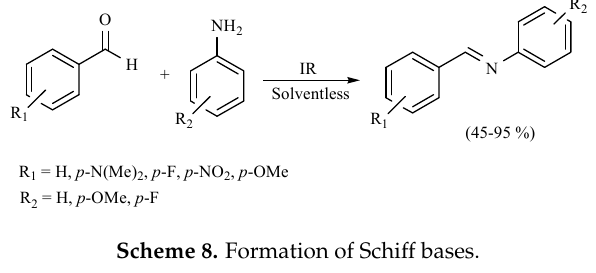
Scheme 8. Formation of Schiff